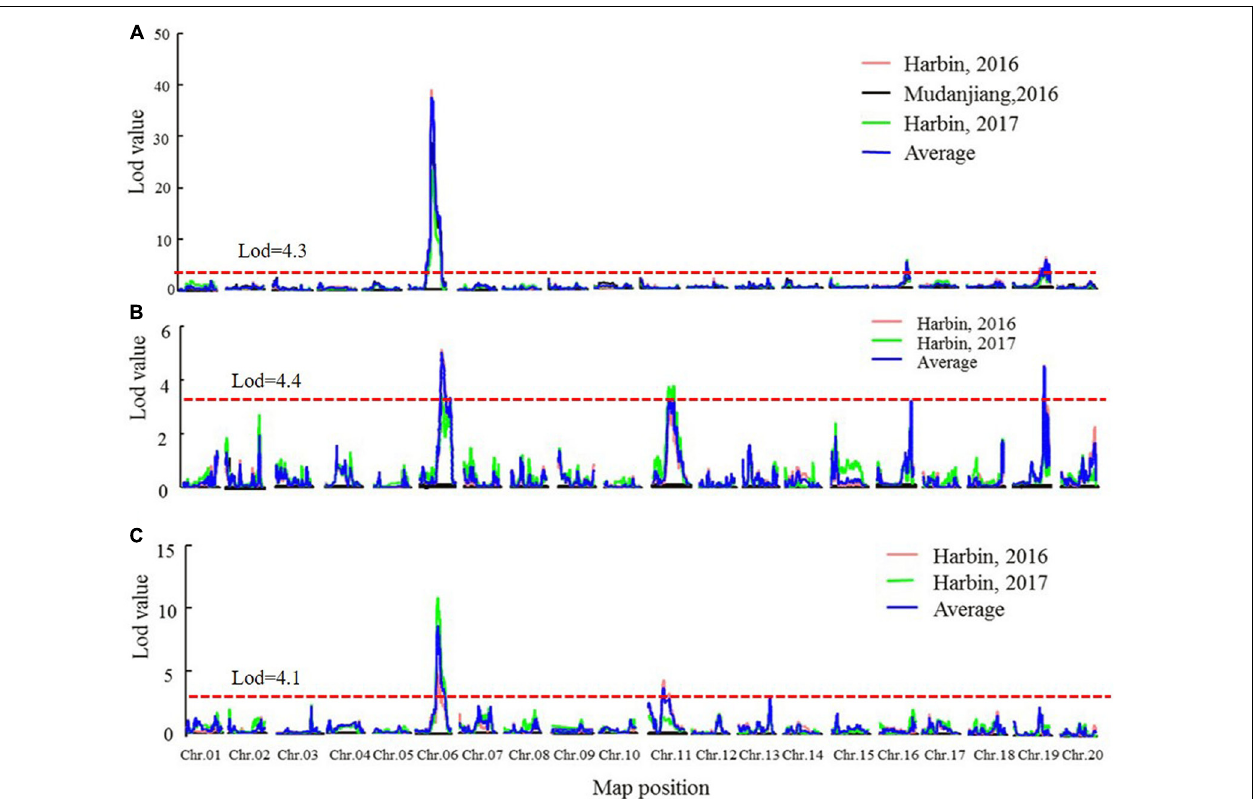
FIGURE 4 | The LOD value of the QTLs detected in SE RIL population under different environments and QTLs detected using the average data of different environments (MQM method). (A) QTLs of Flowering time trait (R1). (B) QTLs of maturity time trait (R8). (C) QTLs of reproductive period trait (RP). Harbin, 2016: The data of year 2016 in Harbin. Mudanjiang, 2016: The data of year 2016 in Mudanjiang. Harbin, 2017: The data of year 2017 in Harbin. Average: the average data in different environments. Chr., chromosome.